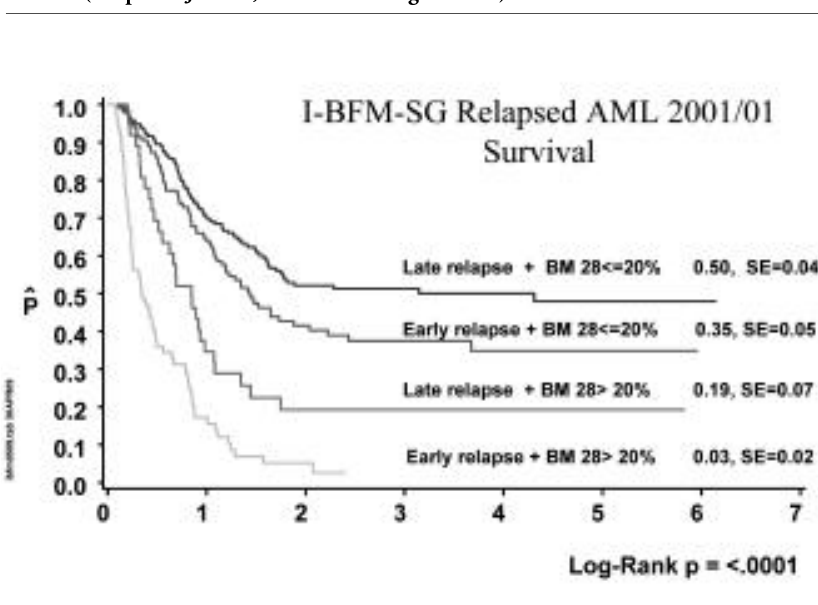
Figura 1 Schema di trattamento del protocollo I-BFM-SG Relapsed AML 2001/01(Kaspers GJL et al, vedi voce bibliografica